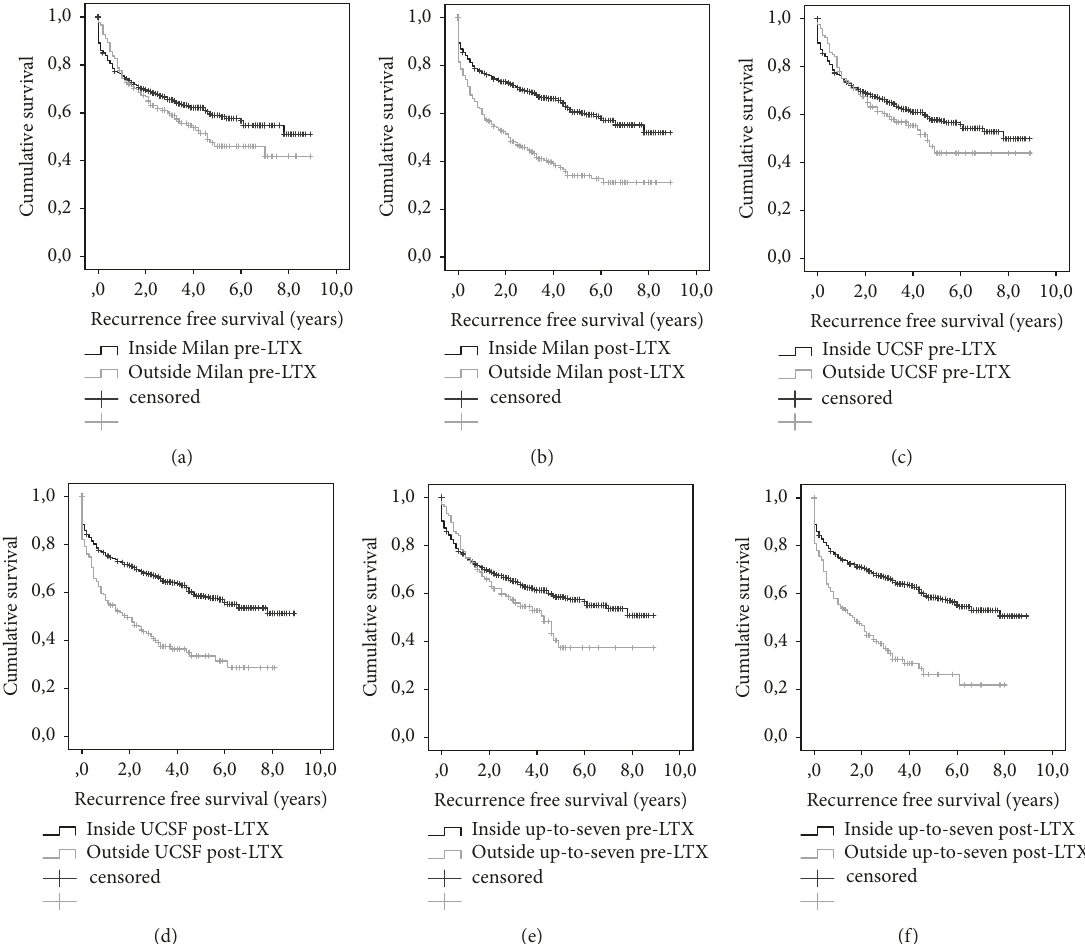
Figure 1: (a + b) Recurrence-free patient survival for patients inside versus outside the Milan criteria based on pretransplant imaging diagnostic (a) or posttransplant histological report (b). (c + d) Recurrence-free patient survival for patients inside versus outside the UCSF criteria based on pretransplant imaging diagnostic (c) or posttransplant histological report (d). (e + f) Recurrence-free patient survival for patients inside versus outside the up-to-seven criteria based on pretransplant imaging diagnostic (e) or posttransplant histological report (f). There was no significant difference in the recurrence-free survival in patients inside versus outside the Milan, UCSF, or up-to-seven criteria based on pretransplant imaging diagnostic (P=0.130; P=0.255; P=0.069). In patients divided by posttranspant histology there was a significant reduced (all P-values 0.001) recurrence-freesurvival for patient outside the Milan, UCSF, or up-to-seven criteria compared to patients inside the